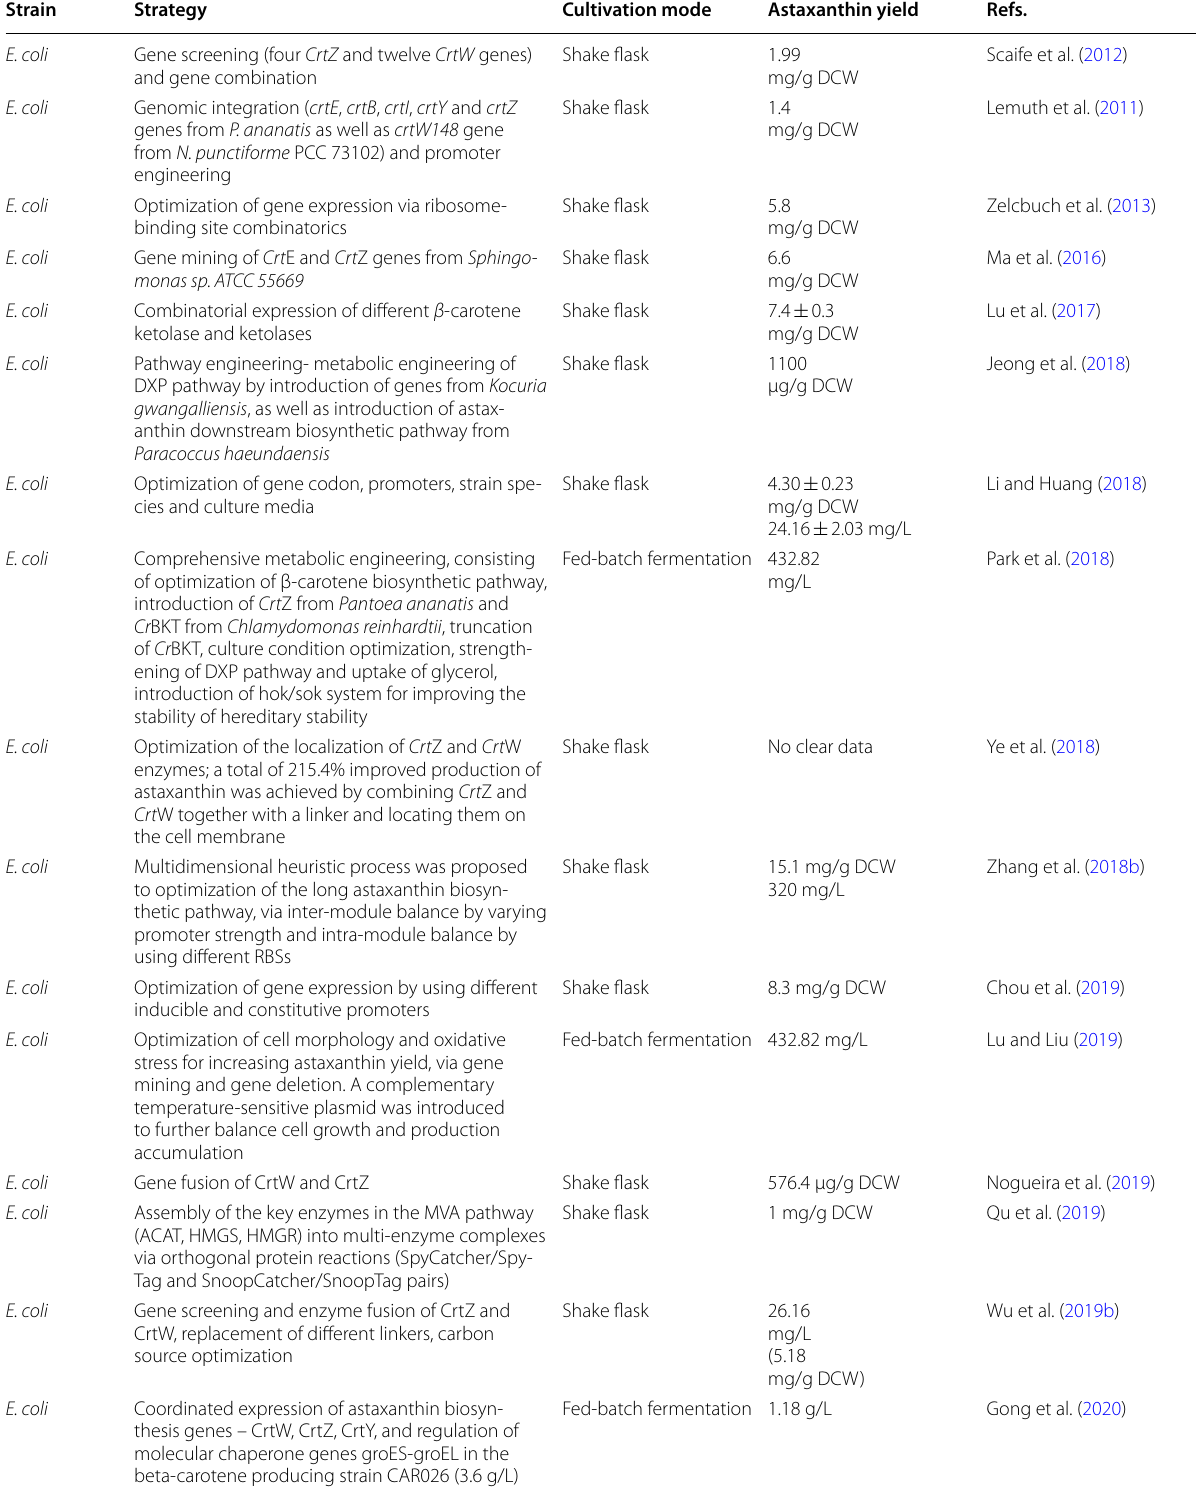
Table 2 Engineering microorganisms for astaxanthin production